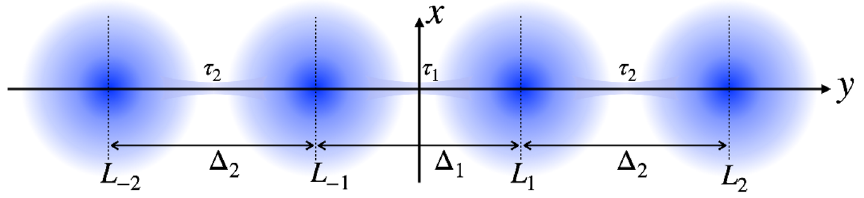
Figure 5 . Schematic picture of the mass density for N = 4 dumbbell with the co-rotating coordi- nate. Thin neck structures exist between